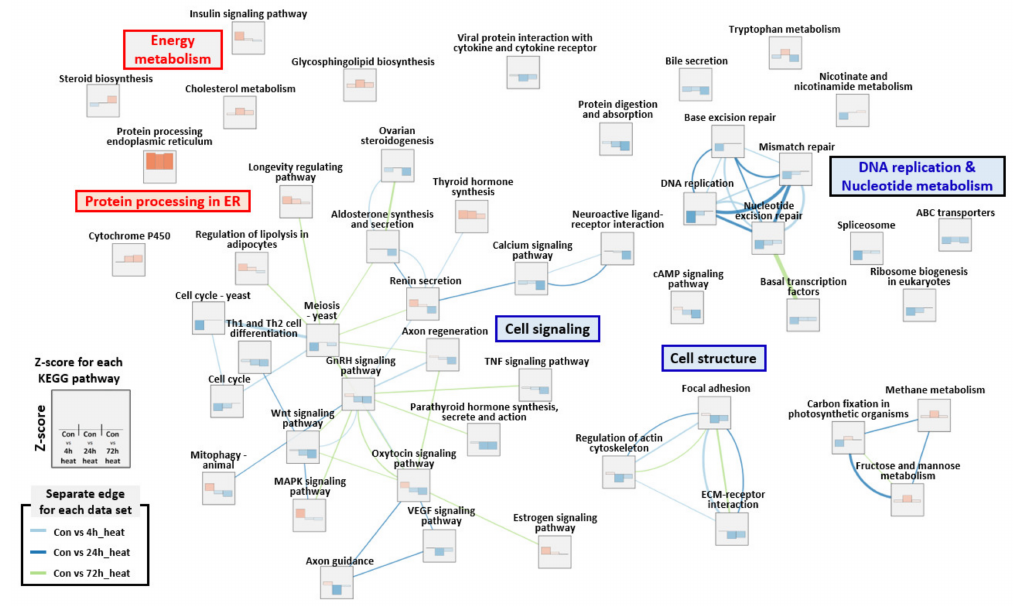
Figure 3. Enrichment map for Kyoto Encyclopedia of Genes and Genomes (KEGG) pathway with Z-score ≥ | 2 | for at least one time point during thermal stress. Normalized enrichment scores at 4, 24, and 72 hpt are shown in each node. The thickness of the light blue, blue, and light green separated edges between nodes indicates the overlap coe ffi cient at 4, 24, and 72 hpt, respectively.